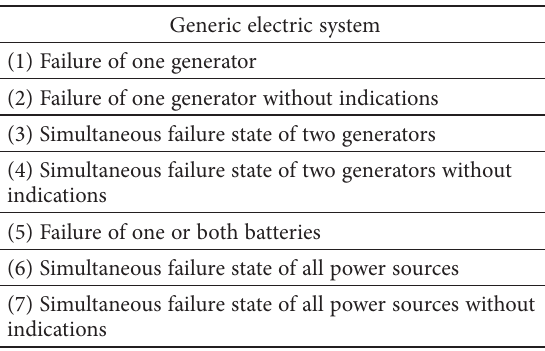
Table 1. Generic electric system failure conditions